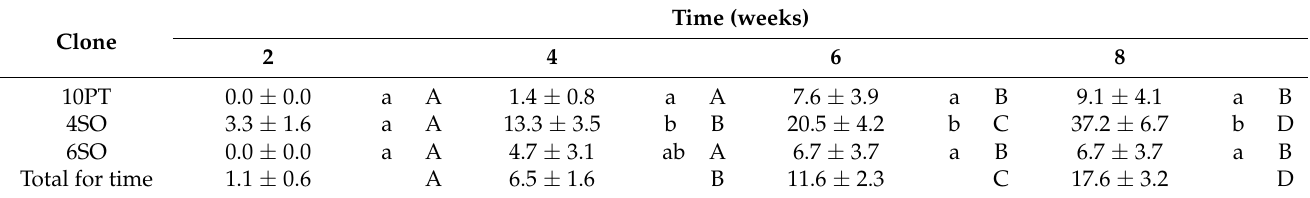
Table 5. Mean ± SE mortality rate M (%) of R. pseudoacacia clones (10PT, 4SO, 6SO) after 2, 4, 6, and 8 weeks of drought stress exposure. Effect of Clone ×